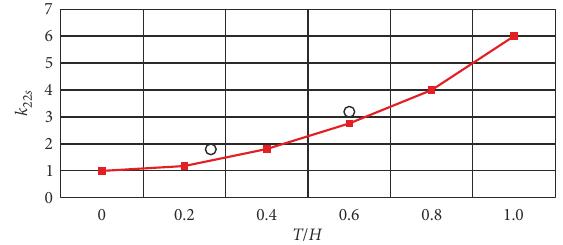
Figure 5. The additional resistance coefficient of the ship k 22 s is subject to the ship’s draft to depth ratio T/H ; o – calculation and experimental For approach channels, recommendations on width calculation, for example PIANC (2014), could be used.